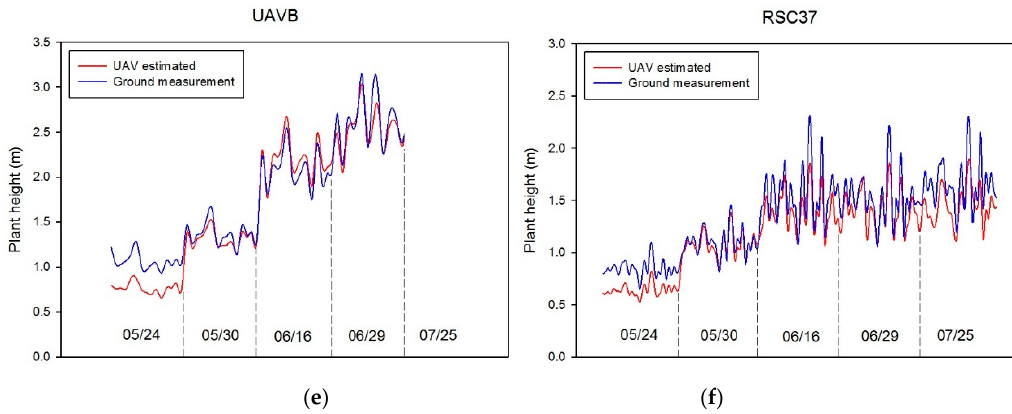
Figure 13. Changes in crop height trends for sorghum at the six experimental tests on ( a ) RSC114, ( b ) RSC135, ( c ) UAVH, ( d ) ADFH, ( e ) UAVB, and ( f ) RSC37 over five flights.